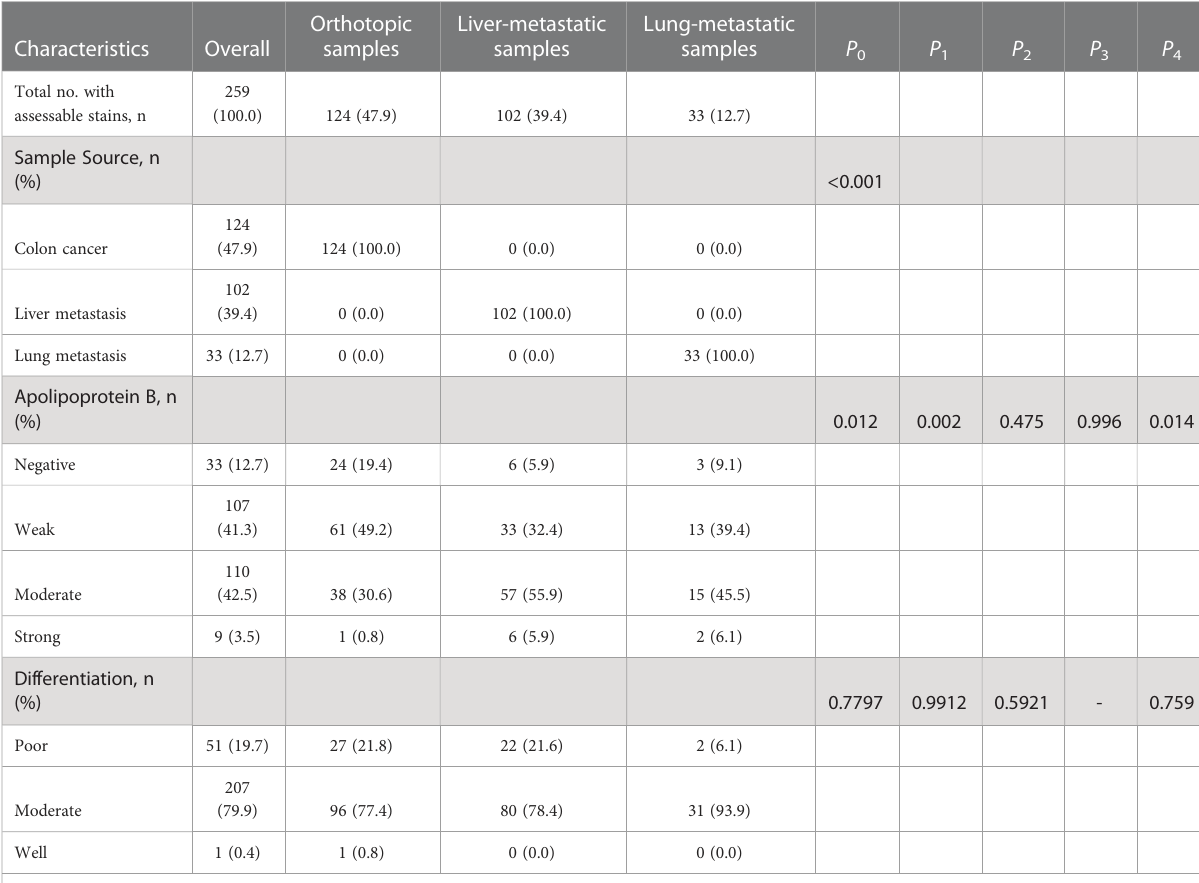
TABLE 2 The 259 colorectal cancer specimens included in this